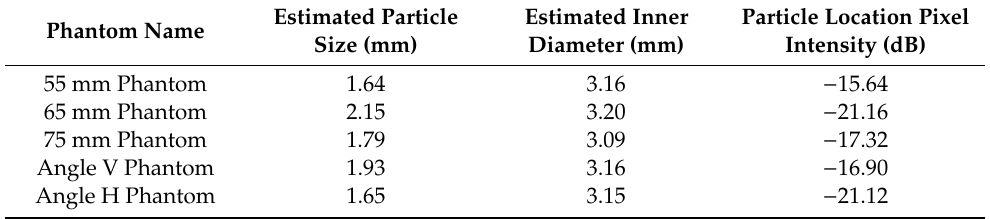
Table 6. Results of applying the particle estimation algorithms to TFM images shown in Figure